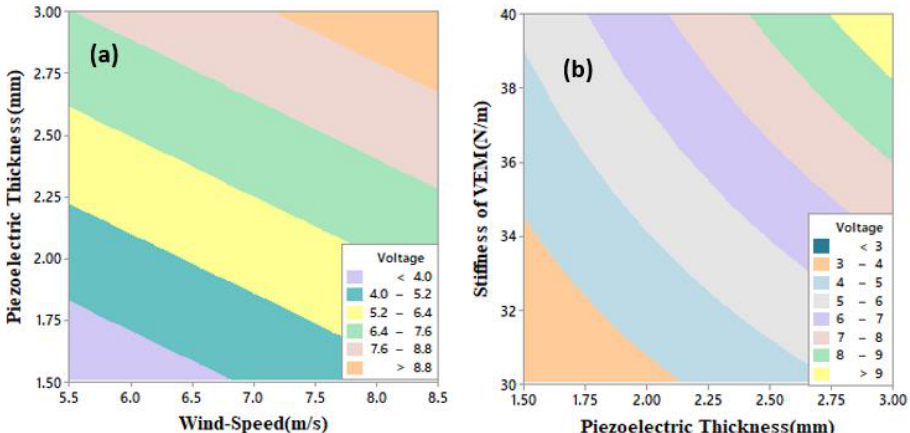
Figure 14. Variation of output voltage in response to dominant factors. ( a ) Wind Speed-Piezoelectric Thickness, ( b ) Piezoelectric Thickness-Stiffness of VEM.